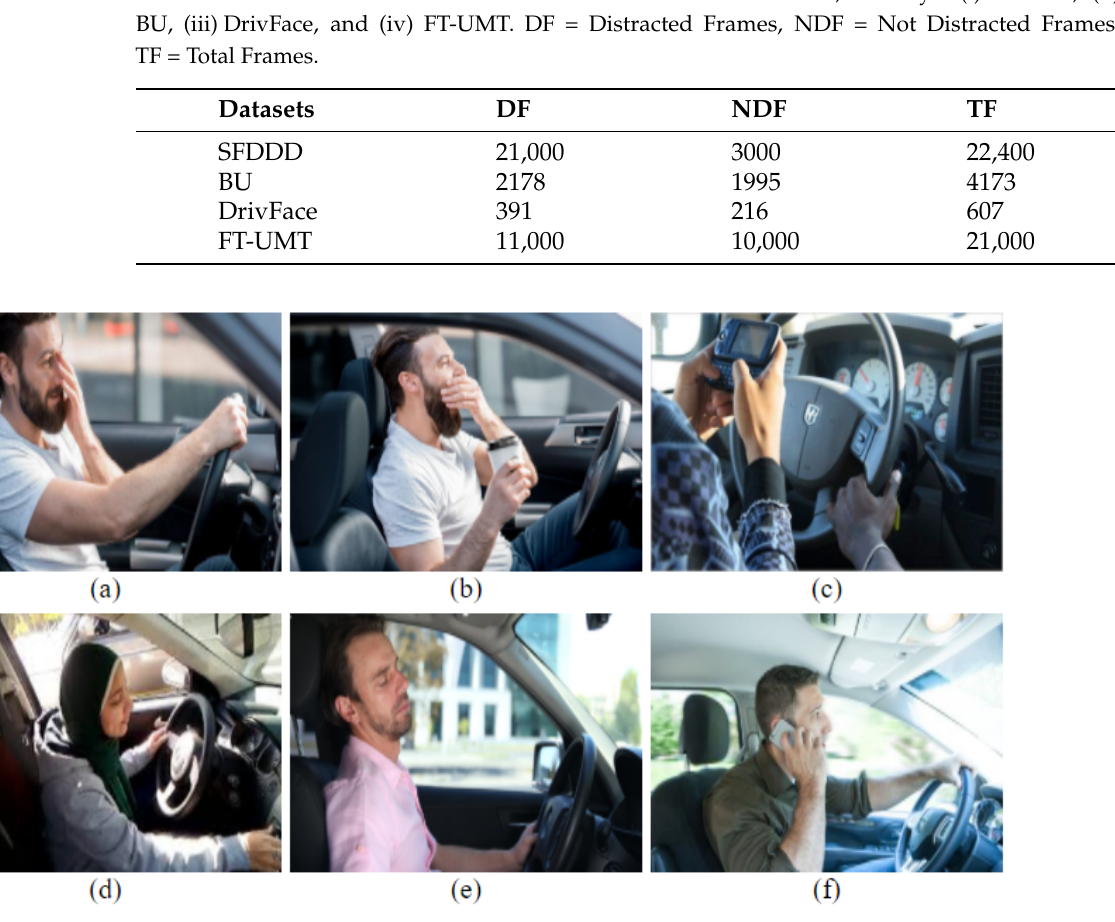
Figure 4. Key frames of the SFDDD showing various distractions, namely: ( a ) drowsiness, ( b ) drinking, ( c ) texting, ( d ) tuning the radio, ( e ) sleeping, and ( f )